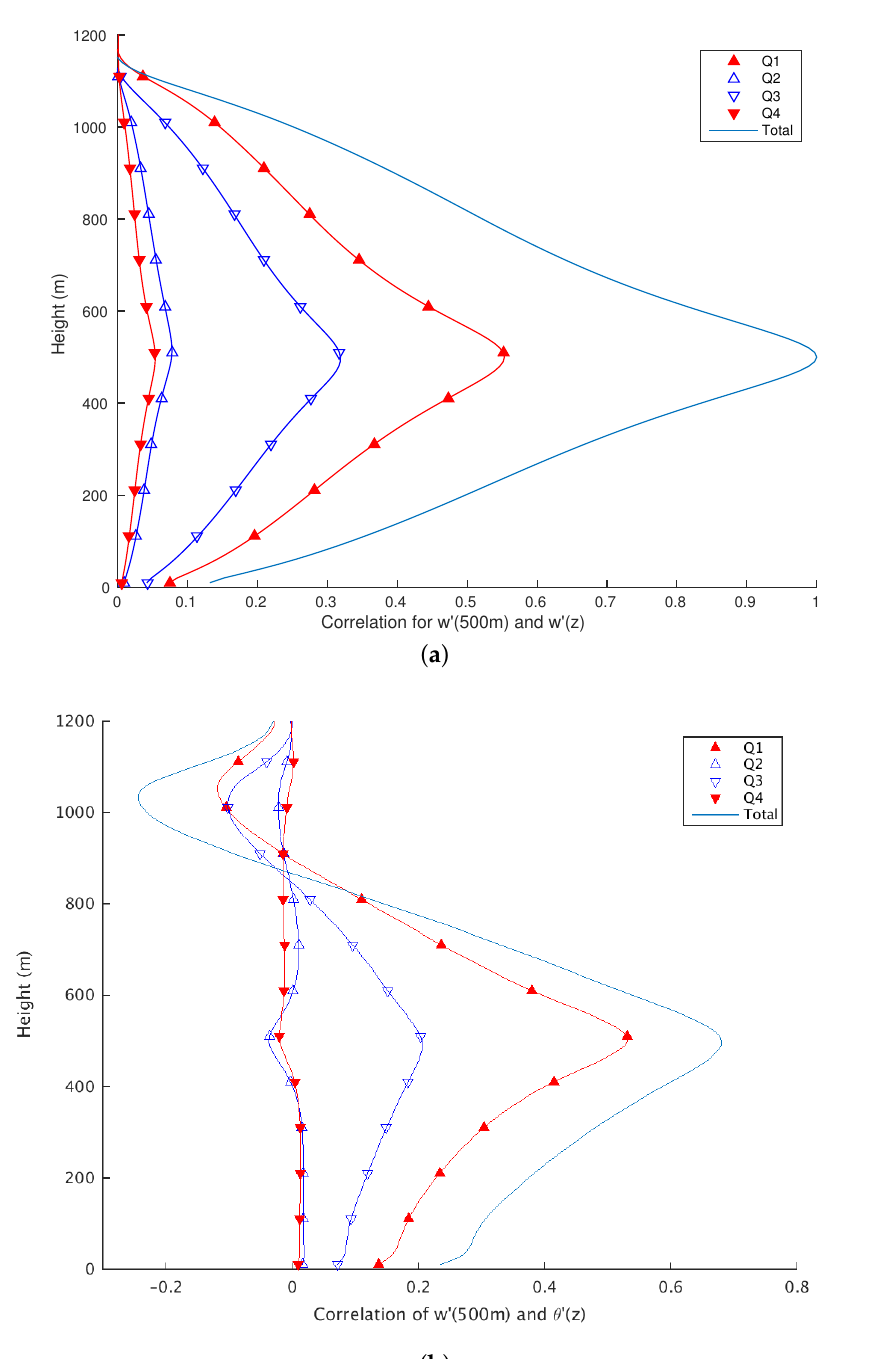
Figure 13. The vertical correlation of the 500 m vertical velocity w in the CBL2 25 m simulation with ( a ) χ = w and ( b ) χ = θ , as defined in Equation (12). The decomposition of the correlation into contributions from each quadrant is also